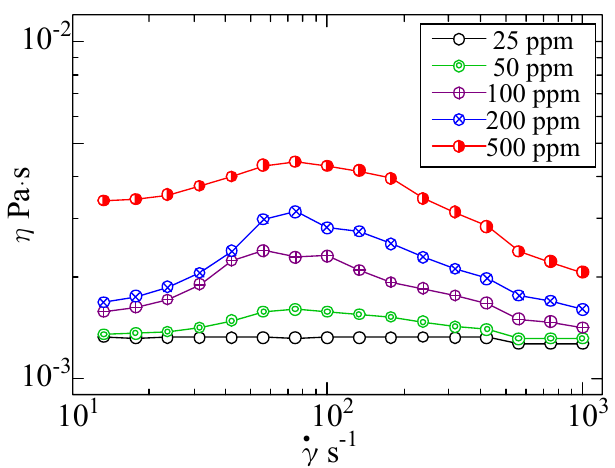
Fig. 2 Apparent viscosity of test surfactant solutions